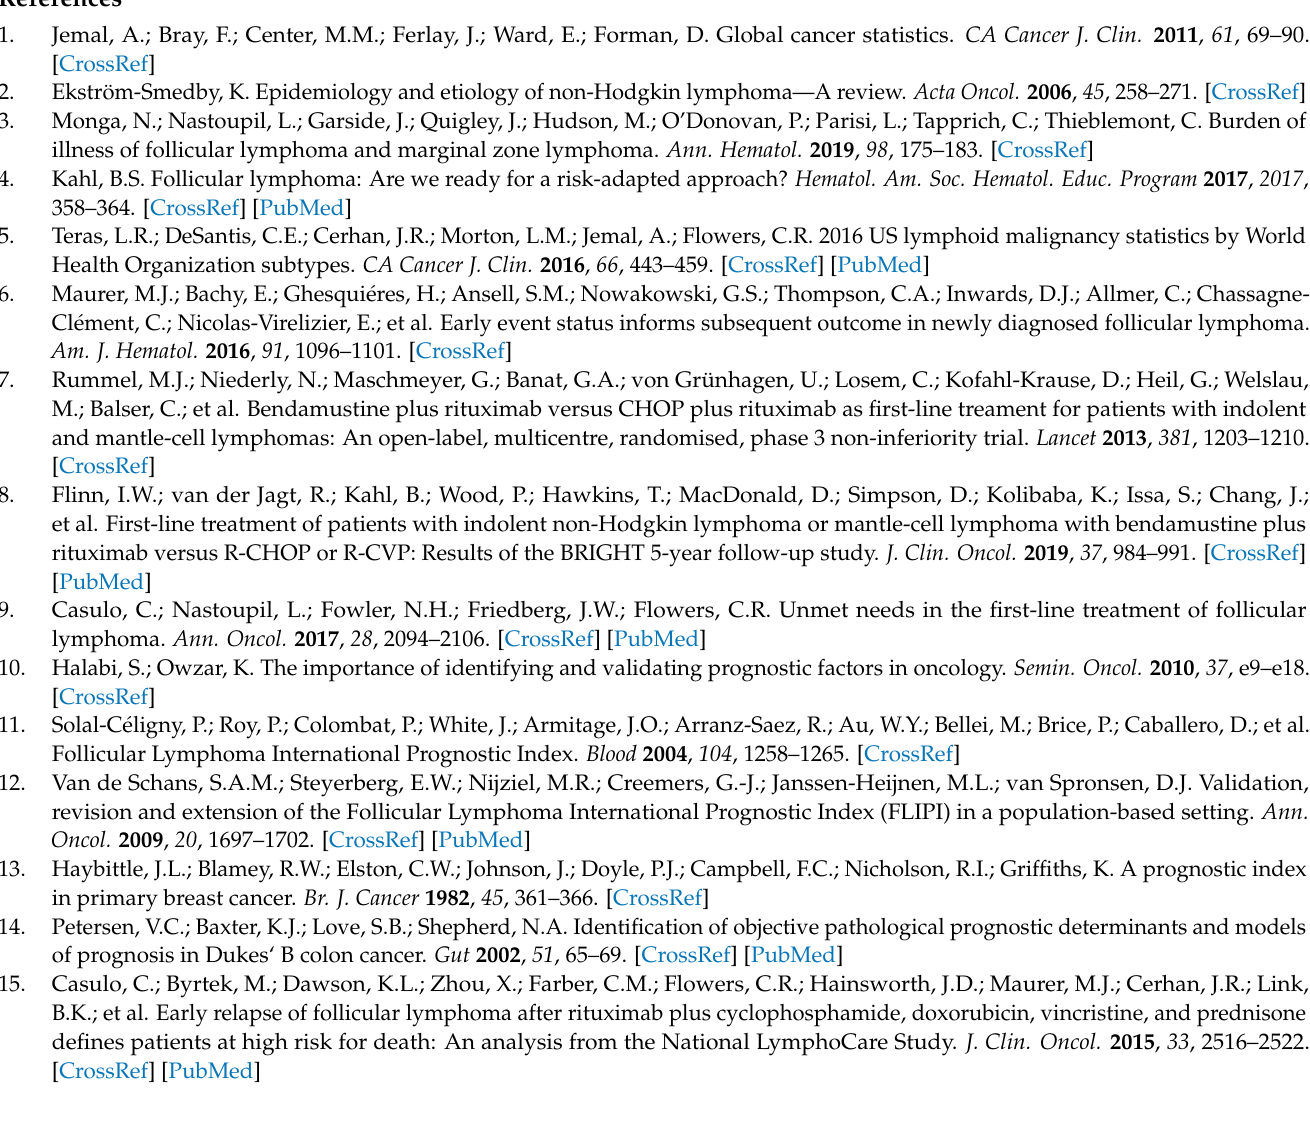
Figure A1. Calibration plots for Cox applied to curated set (AUC [95% CI]: 0.64 [0.61–0.67]), RSF models applied to the curated + labs set (AUC [95% CI]: 0.73 [0.71–0.75]), and Cox applied to curated + POD24 set (AUC [95% CI]: 0.74 [0.71– 0.77]).